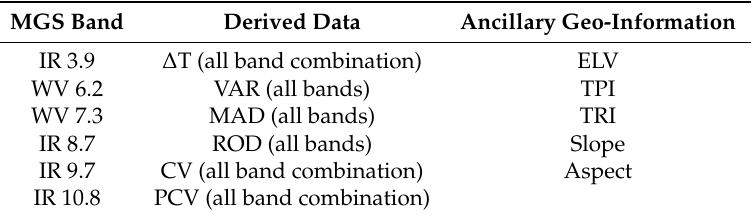
Table 1. All predictors initially used for rainfall retrieval development. MSG bands are shown with their central wavelength in µ m. CV: cross-variogram; ELV: terrain elevation; MAD: madogram; PCV: pseudo CV; ROD: rodogram; TPI: Topographic Position Index; TRI: Topographic Ruggedness Index; VAR: variogram. ∆ T indicates the temperature band differences. WV: Wave